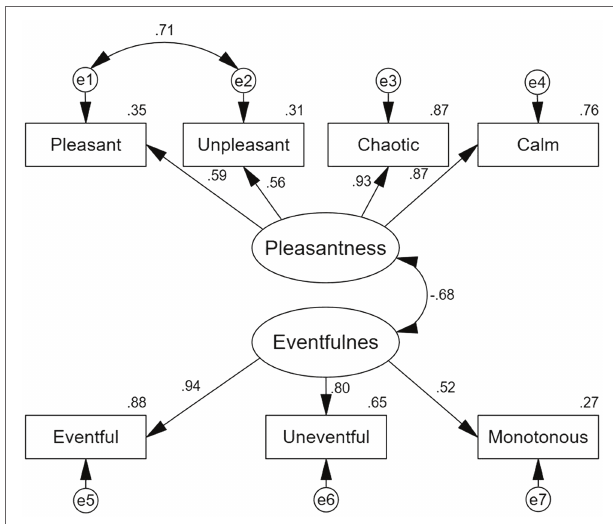
FIGURE 7 | Schematic description of the results for the CFA of the two first order factors ( N = 420). All coefficients are significant at the p < 0.05 level.